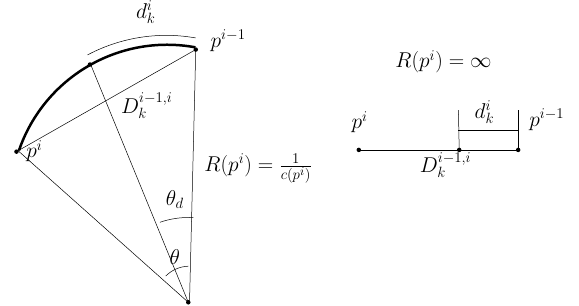
Figure 1. The arc lane connecting p i and p i − 1 is depicted with a bold arc. In the case where R ( p i ) in (6) becomes ∞ , the left sub-figure becomes the right